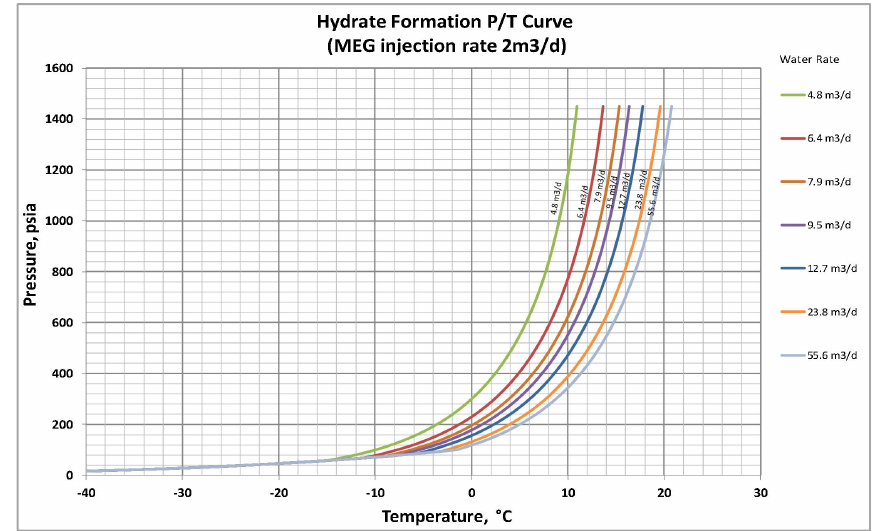
Figure 7—Hydrate formation curve with MEG injection.